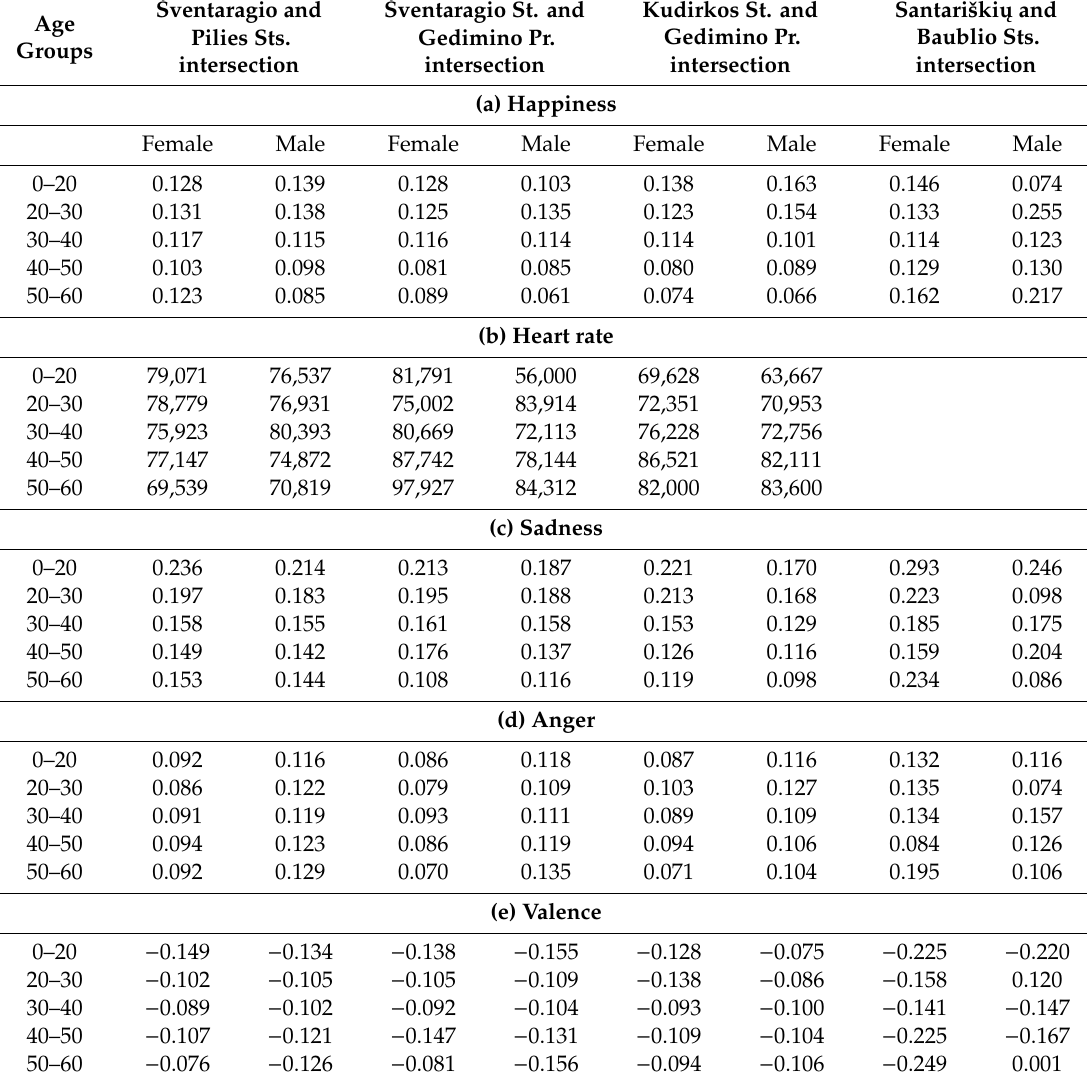
Table 1. A database snippet with AVABEPS variables of passers-by recorded at four intersections in